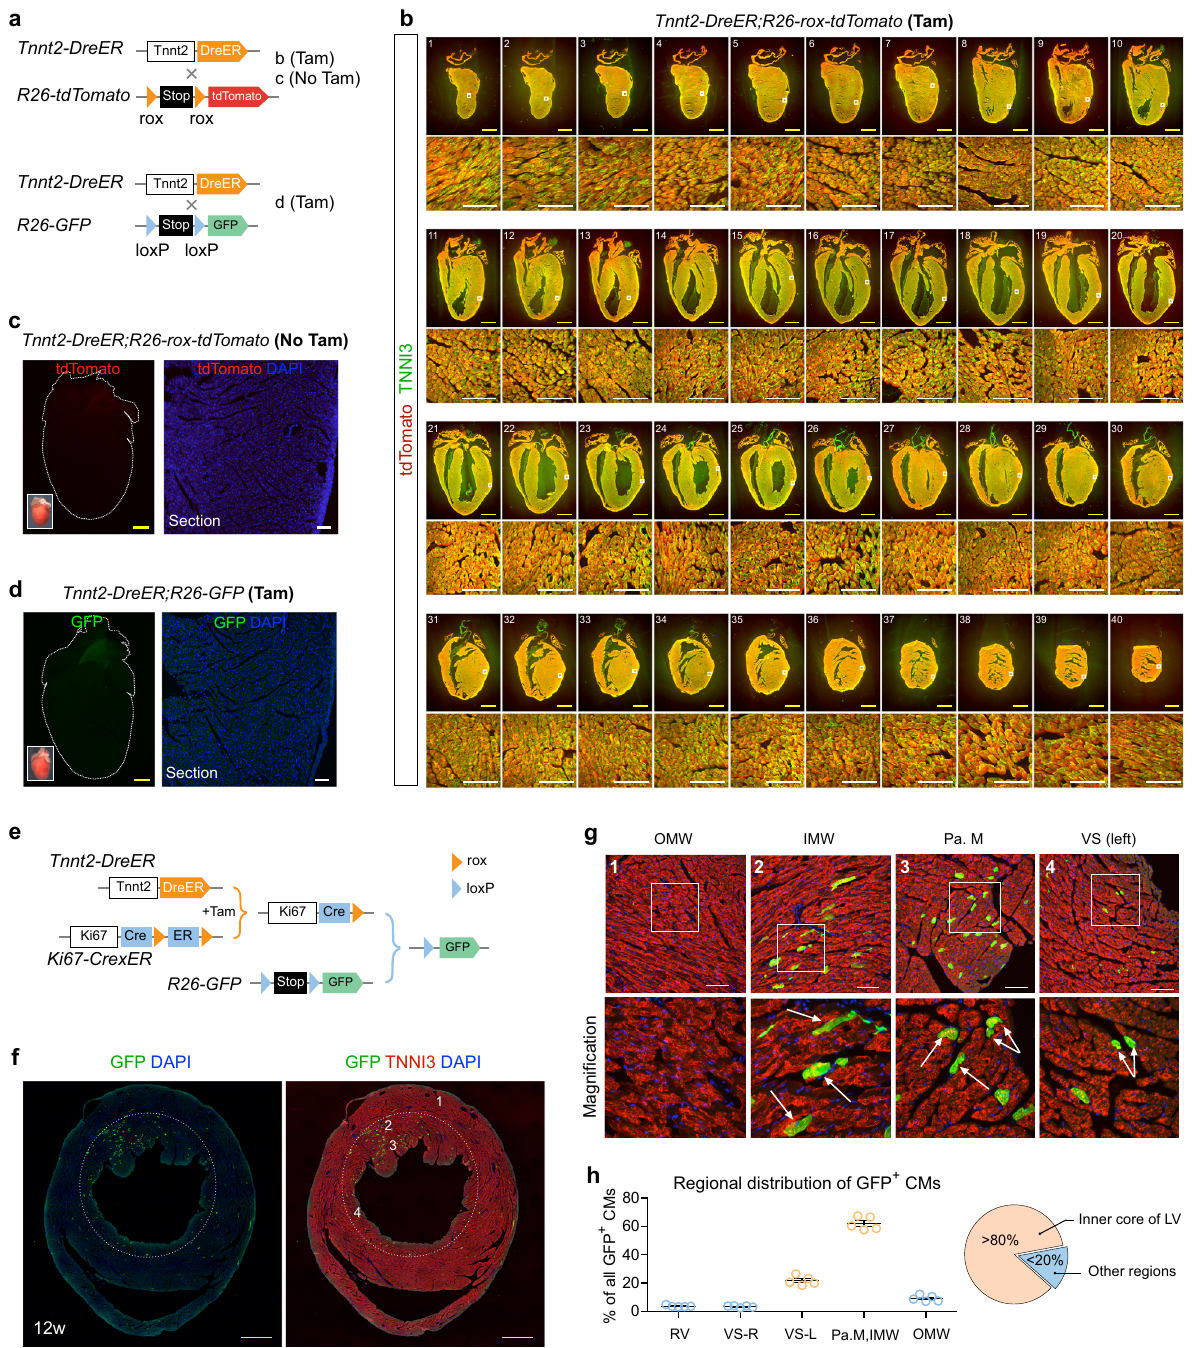
Fig. 4 Tnnt2-DreER triggered ProTracer recording system reveals highly regional cardiomyocyte cell-cycle activity. a Schematic showing crossing of Tnnt2-DreER with rox or loxP reporters. b Immunostaining for tdTomato and TNNI3 on 1 – 40 serial heart sections collected from Tnnt2-DreER ; R26-rox- tdTomato mice treated with tamoxifen (Tam). Boxed regions are magni fi ed in the lower panels. c Whole-mount and sectional fl uorescent images of hearts collected from Tnnt2-DreER ; R26-rox-tdTomato mice without tamoxifen treatment (No Tam). d Whole-mount and sectional fl uorescent images of hearts collected from Tnnt2-DreER ; R26-GFP mice treated with tamoxifen (Tam). e Schematic showing a strategy using Tnnt2-DreER to prime ProTracer system for recording of cardiomyocyte cell-cycle activity. f , g Immunostaining for GFP and TNNI3 on Tnnt2-DreER ; Ki67-CrexER ; R26-GFP heart sections. Numbered regions (1,2,3,4) are magni fi ed on the ( g ) panels. Arrows, GFP + cardiomyocytes. OMW outer myocardial wall, IMW inner myocardial wall, Pa. M papillary muscle, VS ventricular septum. h Quanti fi cation of the distribution of GFP + CMs in different regions of hearts. Data are mean ± s.e.m.; n = 5. Scale bars: yellow, 1 mm; white, 100 µ m. Each fi gure is representative of fi ve individual biological